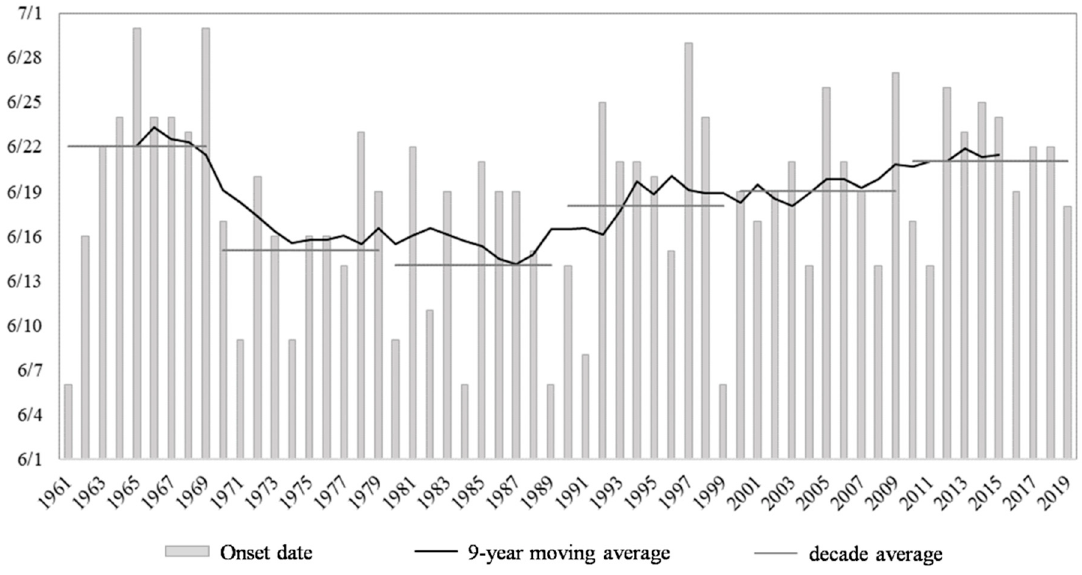
Figure 1. Onset date and interannual and interdecadal sequence of Meiyu in Jiangsu Province from 1961 to 2019.